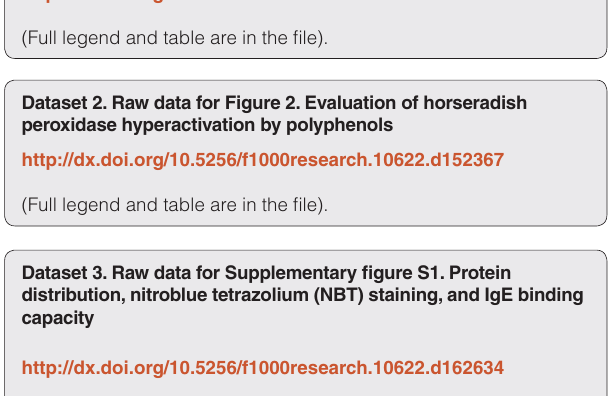
Dataset 3: Raw data for Supplementary Figure S1. Protein distribution, nitroblue tetrazolium (NBT) staining, and IgE binding capacity. (Full legend and table are in the file). DOI, 10.5256/f1000research.10622.d162634